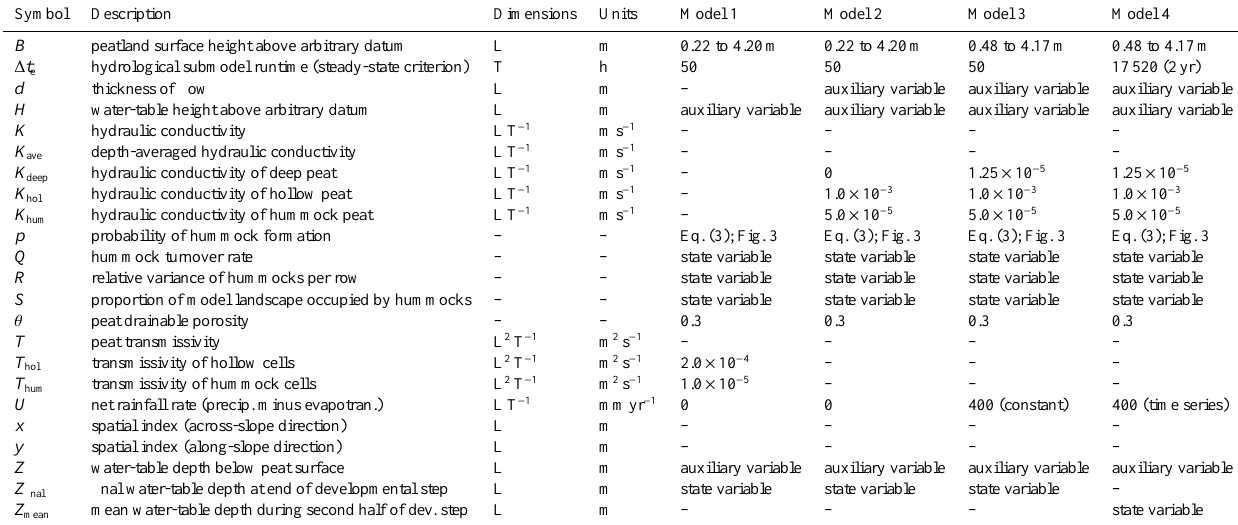
Table 1. Glossary of algebraic terms, including default values where appropriate, for each of the four model